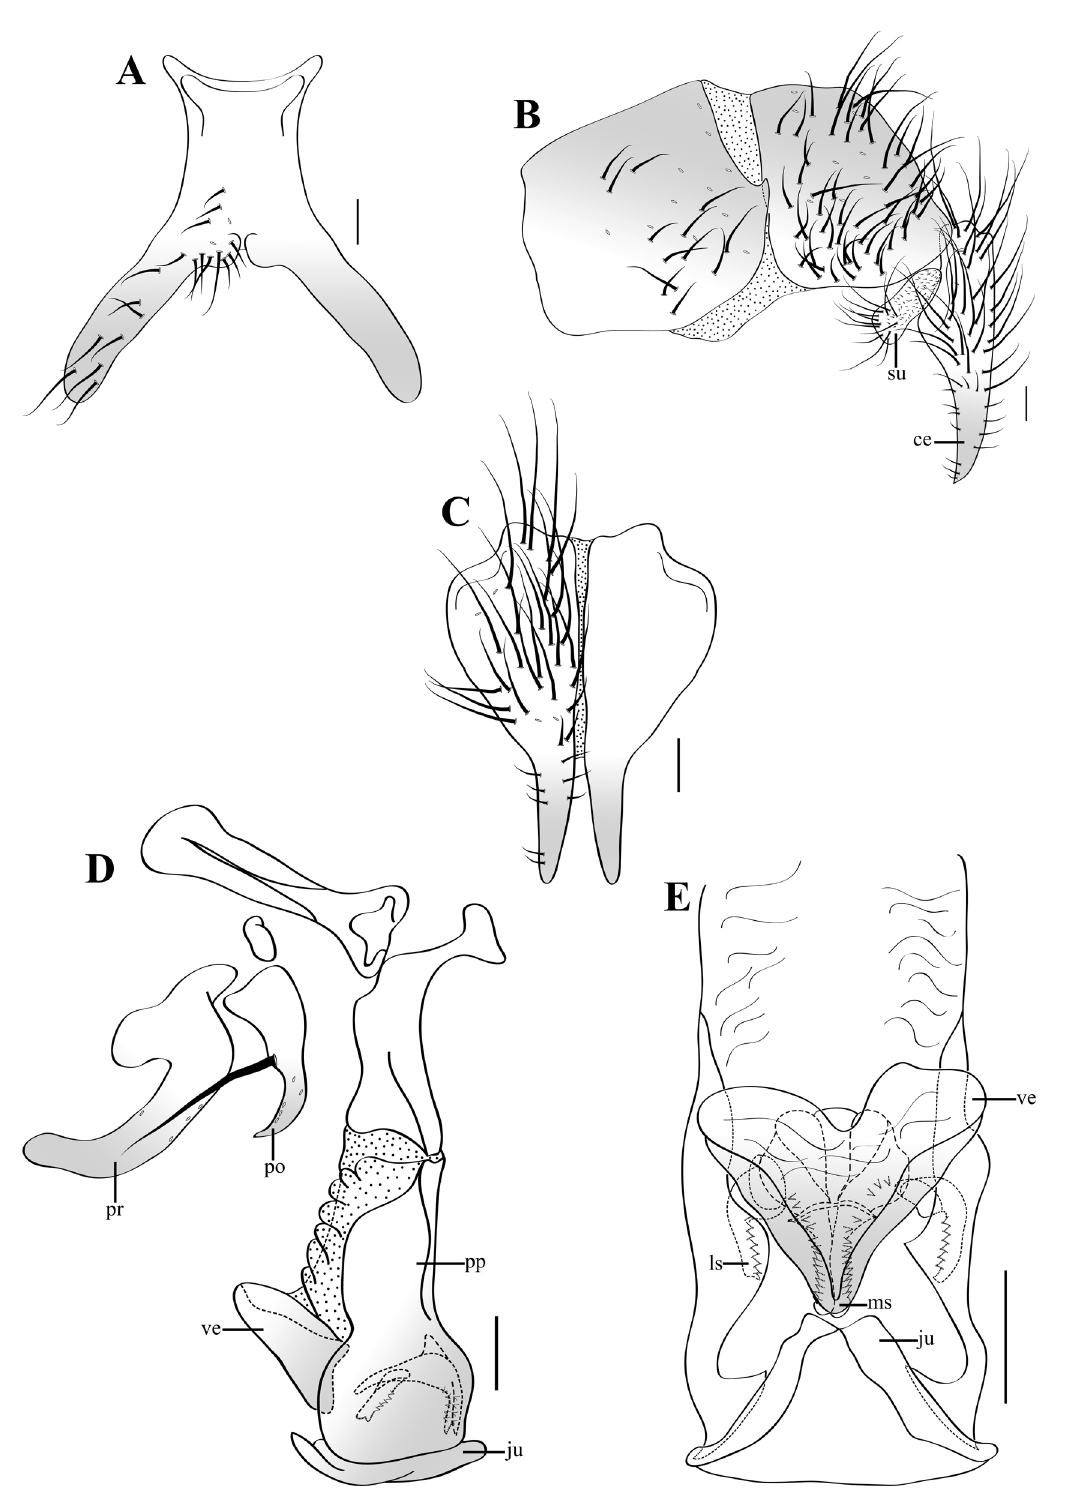
Fig. 1. Dexosarcophaga phoenix sp. nov., ♂, paratype (MNRJ [lost]), Brazil, Brasília, Distrito Federal. A . Sternite 5, ventral view. B . Syntergosternite 7 + 8, epandrium, cercus and surstylus, lateral view. C . Cerci, posterior view. D . Phallus and associated structures, lateral view. E . Distiphallus, ventral view. Abbreviations: see Material and methods. Scale bars = 0.1